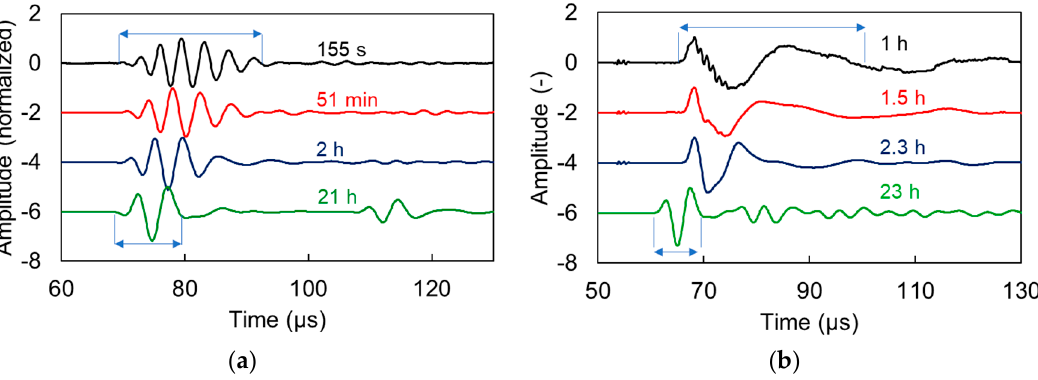
Figure 13. Waveforms at different times for ( a ) shampoo and ( b ) reference cement mortar.